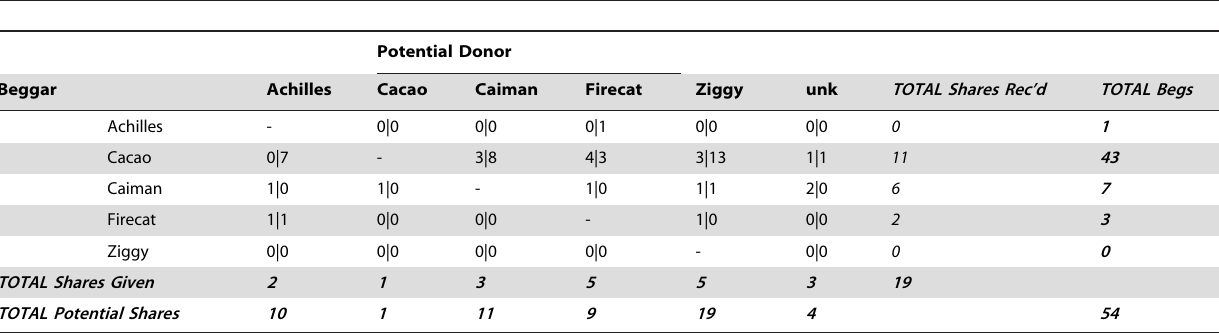
Table 2. Matrix of counts of shares|no shares observed between all beggars and potential donors, September 2007.